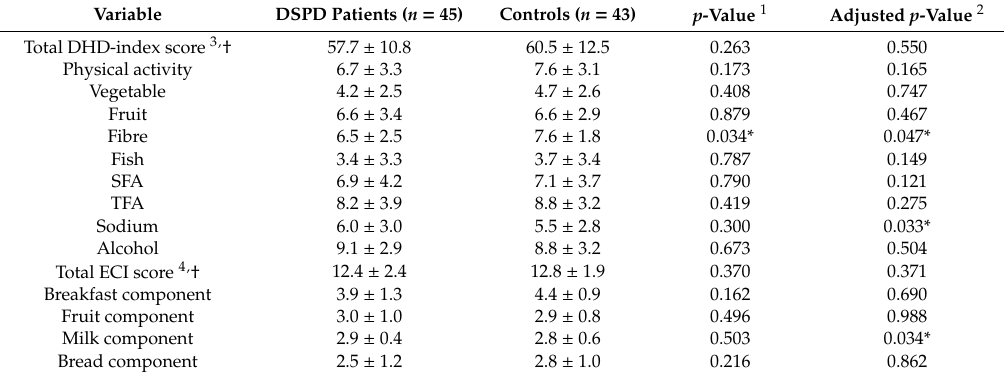
Table 3. Total DHD-index score, total Eating Choices Index (ECI) score and individual components of the DHD-index score and ECI score in DSPD patients compared with controls. Values are presented as mean ±